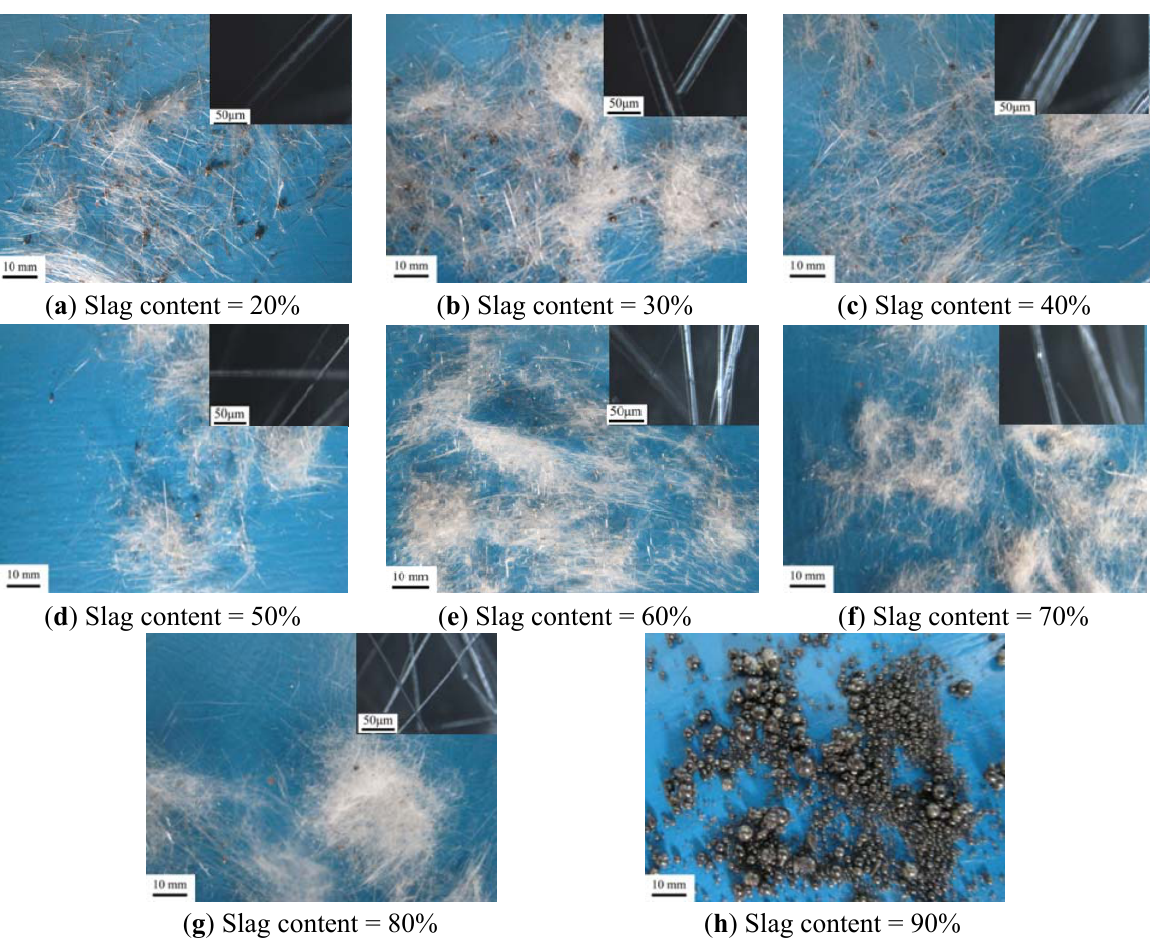
Figure 5. Morphology of slag fibers at different content of the blast slag and the coal ash produced at 1450